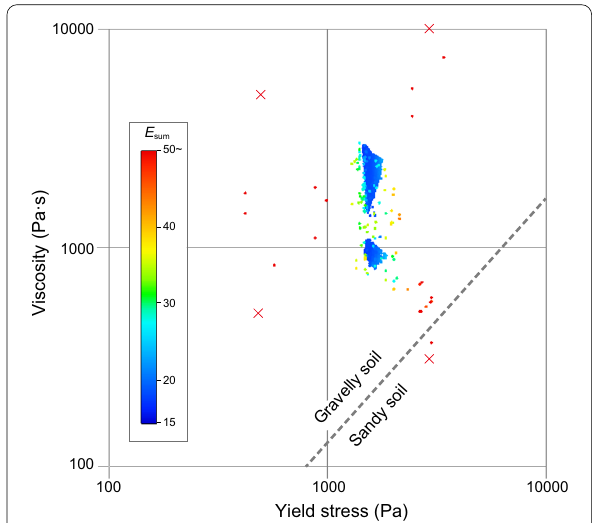
Fig. 3 Yield stress–viscosity diagram showing the results of the MCMC simulation. Initial values are shown by red crosses. Resulting values are plotted with their corresponding E sum value indicated by the color scale. The inferred boundary between gravel-rich and sand-rich soils (grey dash line) is from Jeong et al. (2010)